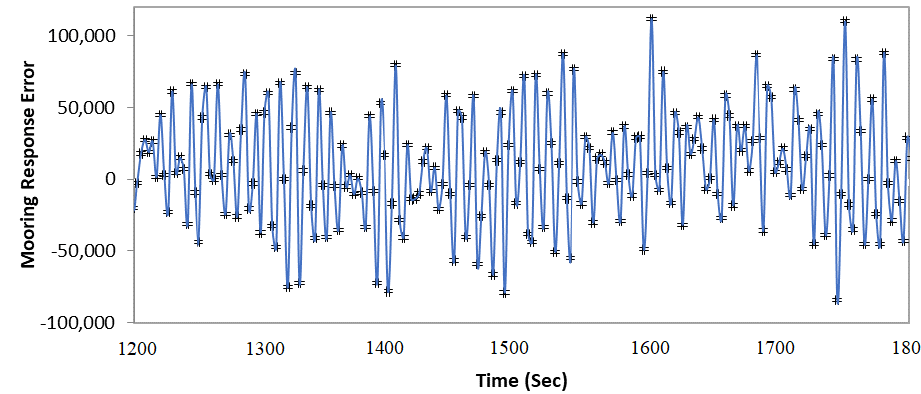
Figure 17. The mooring line response error between ANN and FEM for 12.65 m wave height and 11.39 s wave period.